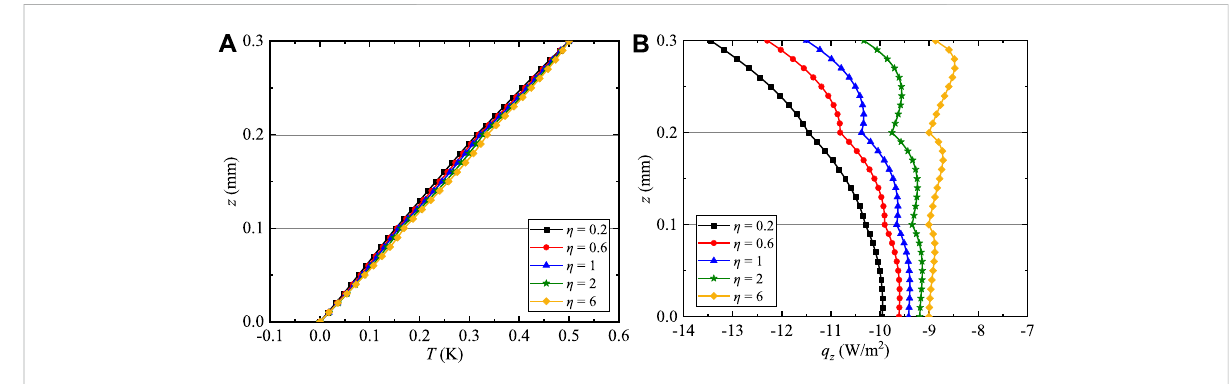
FIGURE 5 Variation of the temperature and heat fl ux for QC coating structures: (A) T and (B) q z .